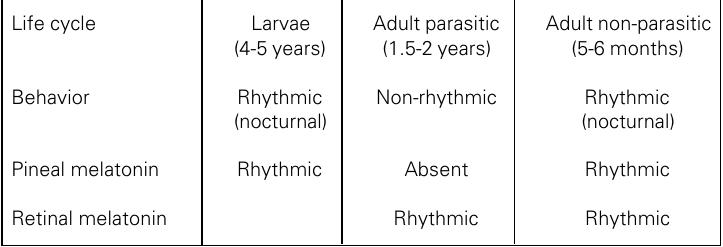
Figure 1 - Schematic representation of the life cycle of the sea lamprey Petromyzon marinus . This cyclostome has a complex life cycle with three different phases: larval, adult parasitic, and adult non-parasitic. Melatonin is rhythmically synthesized by the pineal during the larval and non-parasitic adult stages, but not during the adult parasitic stage (see text). Retinal melatonin is synthesized rhythmically in both the parasitic and non-parasitic adult stages. In the larval stage the retina is not yet fully developed and so far we have not been able to culture it (compiled with data from Refs.